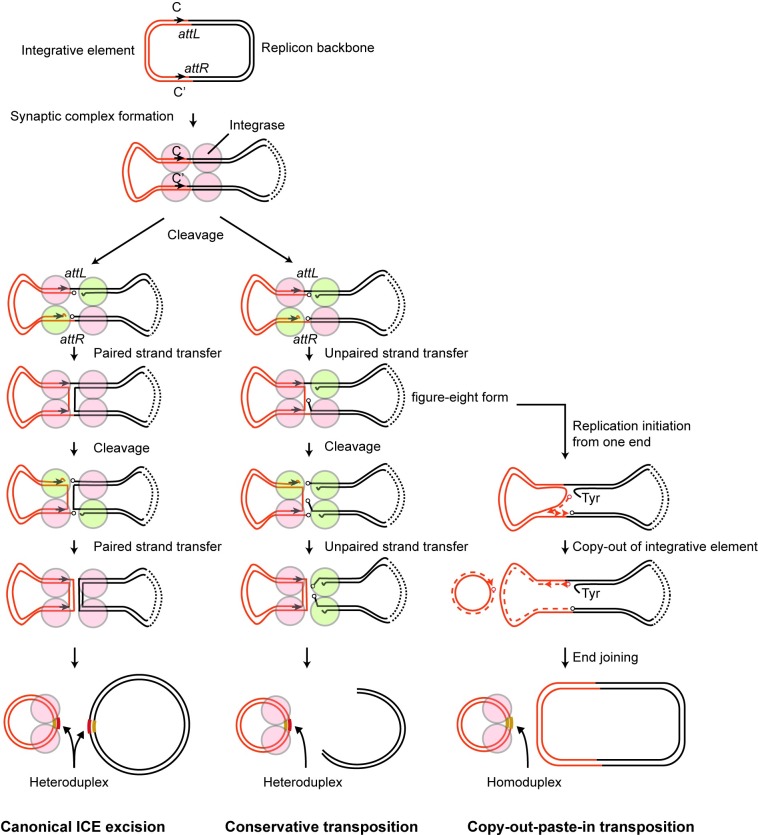
Models for Tn6283 excision pathway.(Left) Canonical ICE excision. Red: inactive tyrosine recombinase protomer; green, active recombinase protomer. Two rounds of paired strand transfer separate the integrative element and replicon backbone. (Middle) Conservative transposition. Strand transfer occurs on only one strand upon every strand cleavage reaction. This leads to a double-strand break of the donor replicon, similar to the transposition of IS10 and Tn7 [60, 61]. (Right) Copy-out-paste-in transposition. Strand synthesis after the first strand transfer excises the integrative element without cleaving one strand of the parental molecule. Progression of the replication fork generates the circular form of the integrative element, leaving its original copy in the donor molecule.